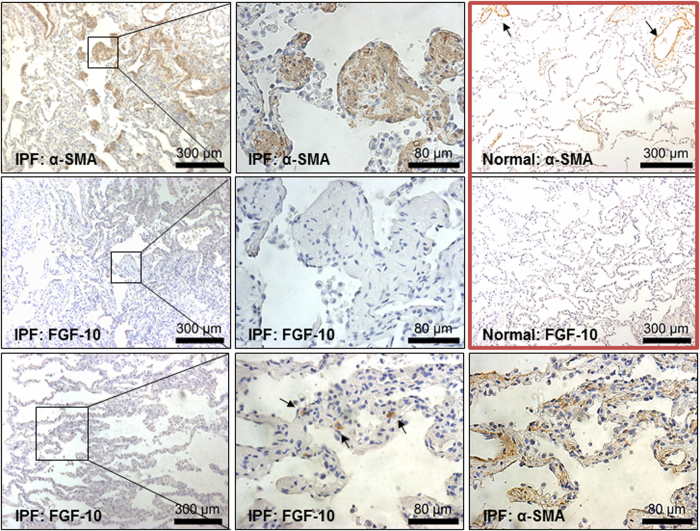
Immunohistochemical localization of α-SMA and FGF-10 in IPF and normal lungs.Six micron (6 μ) sections were obtained from normal (n = 4, failed donor lung) and IPF (n = 4; explant during lung transplantation). Immunohistochemical staining showing expression of the myofibroblast marker, α-SMA, in fibroblastic foci of IPF lung tissues; note that α-SMA staining in normal lung is restricted to large airways and blood vessels (arrows). FGF-10 immunostaining was not detected in the fibroblastic foci although expression of this growth factor was observed in interstitial mesenchymal cells in regions with less fibrotic remodeling (arrows). Higher magnification images of specific regions (boxes) are shown in middle panels.